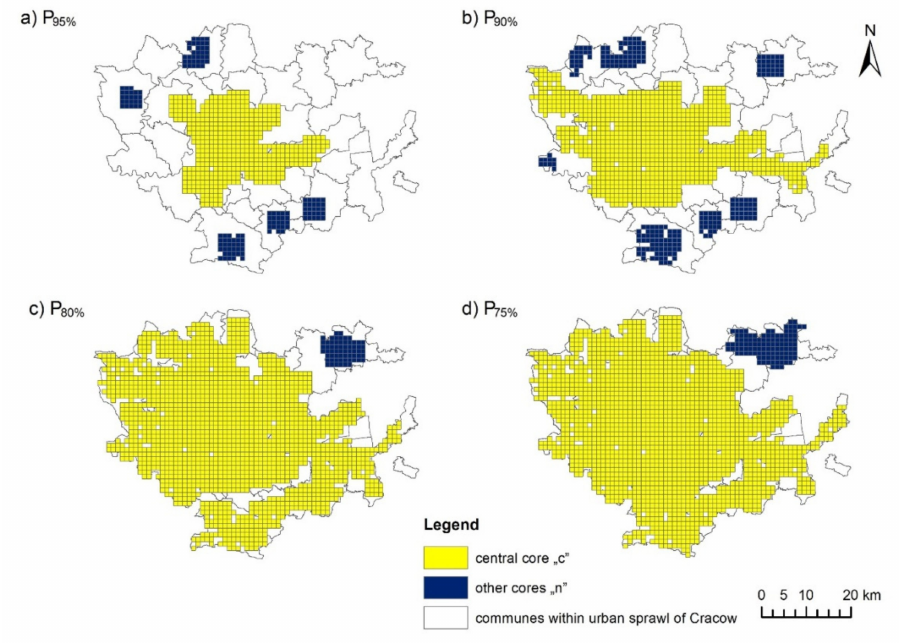
Figure 3. Nuclearity in the Cracow area with the building density for all squares grid: ( a ) P 95% , ( b ) P 90% , ( c ) P 80% , ( d ) P 75%